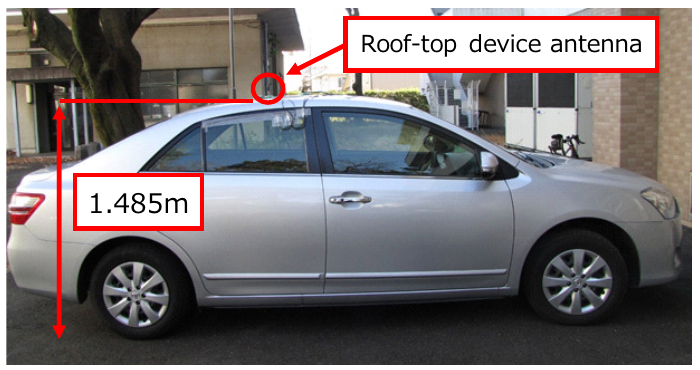
Figure 3. Observation vehicle.